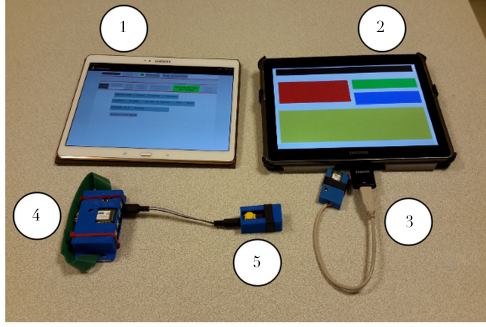
Figure 1. TactiNET: hardware setup.